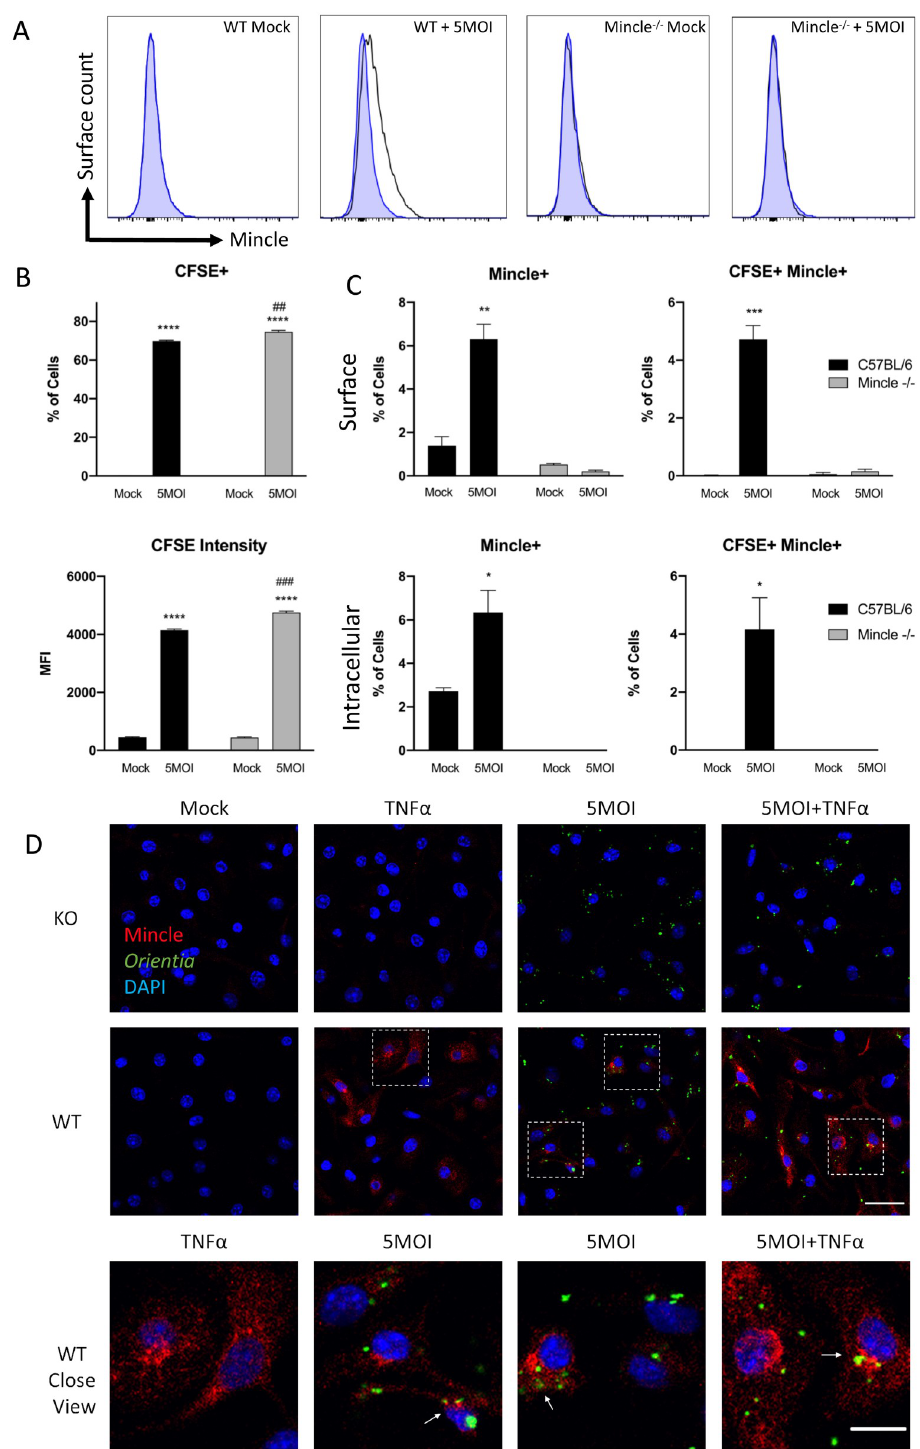
Fig 8. Mincle-expressing M F are increased during infection and promoted by TNF α . Bone marrow-derived WT or Mincle -/- M F were exposed to O . tsutsugamushi (5 MOI) and analyzed via flow cytometry and IFA at 4 hr post- infection. (A) Representative frequencies of Mincle + cells detected for surface staining, with WT and Mincle -/- treatment groups compared with WT mock samples (blue). (B) The percentage and mean fluorescent intensity (MFI) of CFSE + cells are shown for intracellularly stained M F s among bacterium-carry (CFSE + ) cells. (C) A comparison of